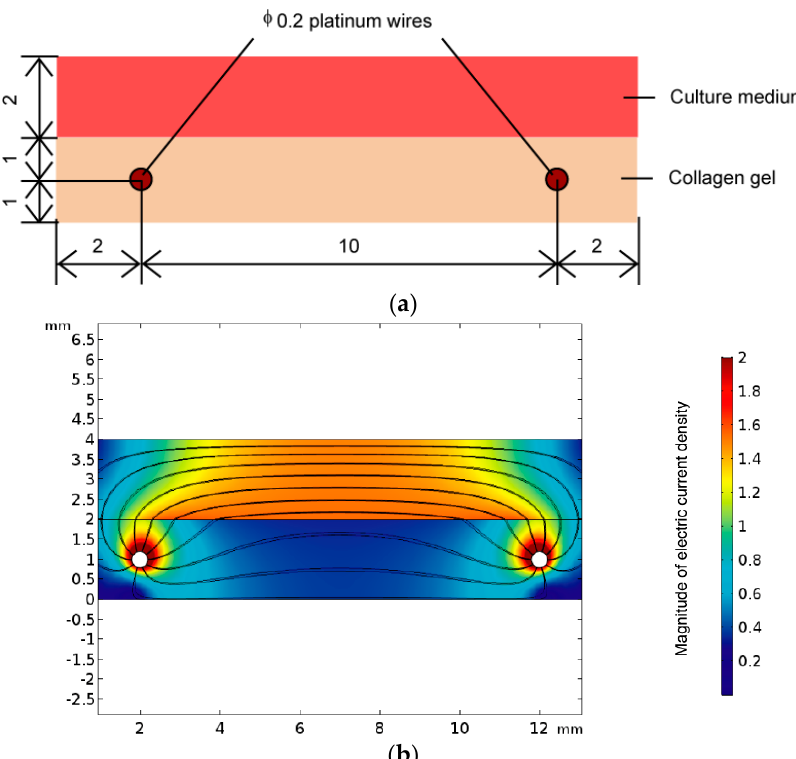
Figure 2. ( a ) Numerical analysis model of electrical field. ( b ) Pathway of electric currents between two platinum wires in the cell culture region. Streamlines show the pathway of the electric current, and the contour plot shows the magnitude of the electric current density.